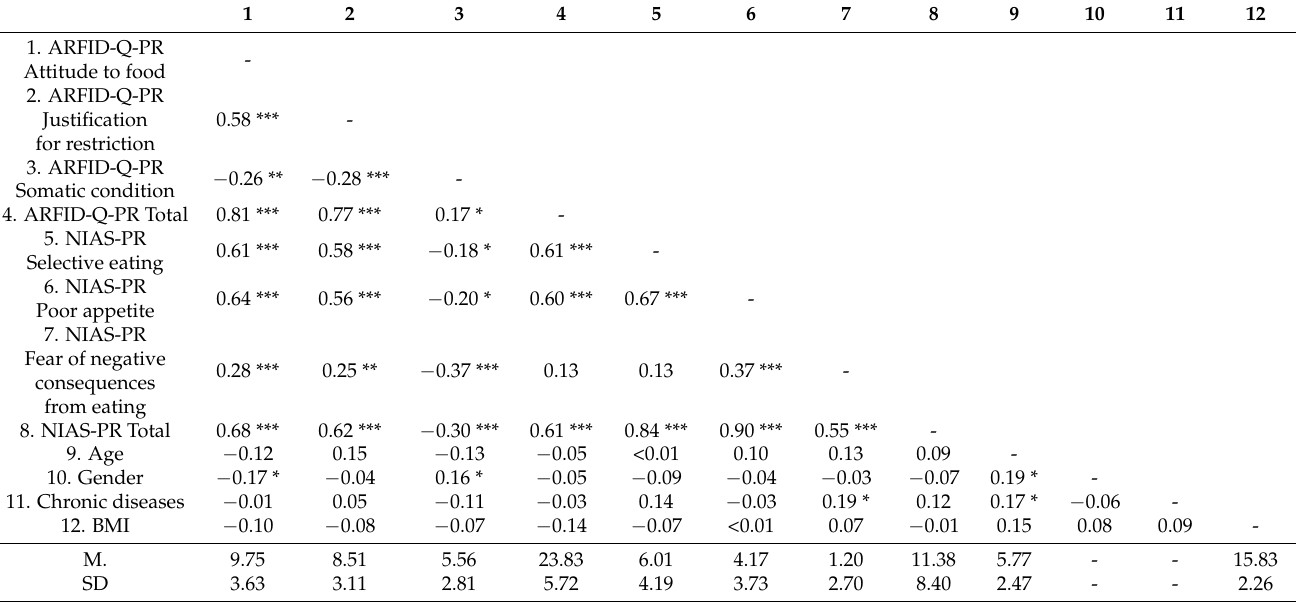
Table 4. Pearson’s r correlations subscales for ARFID-Q-PR with NIAS-PR and age, gender, chronic diseases, BMI, means, and standard deviations of individual